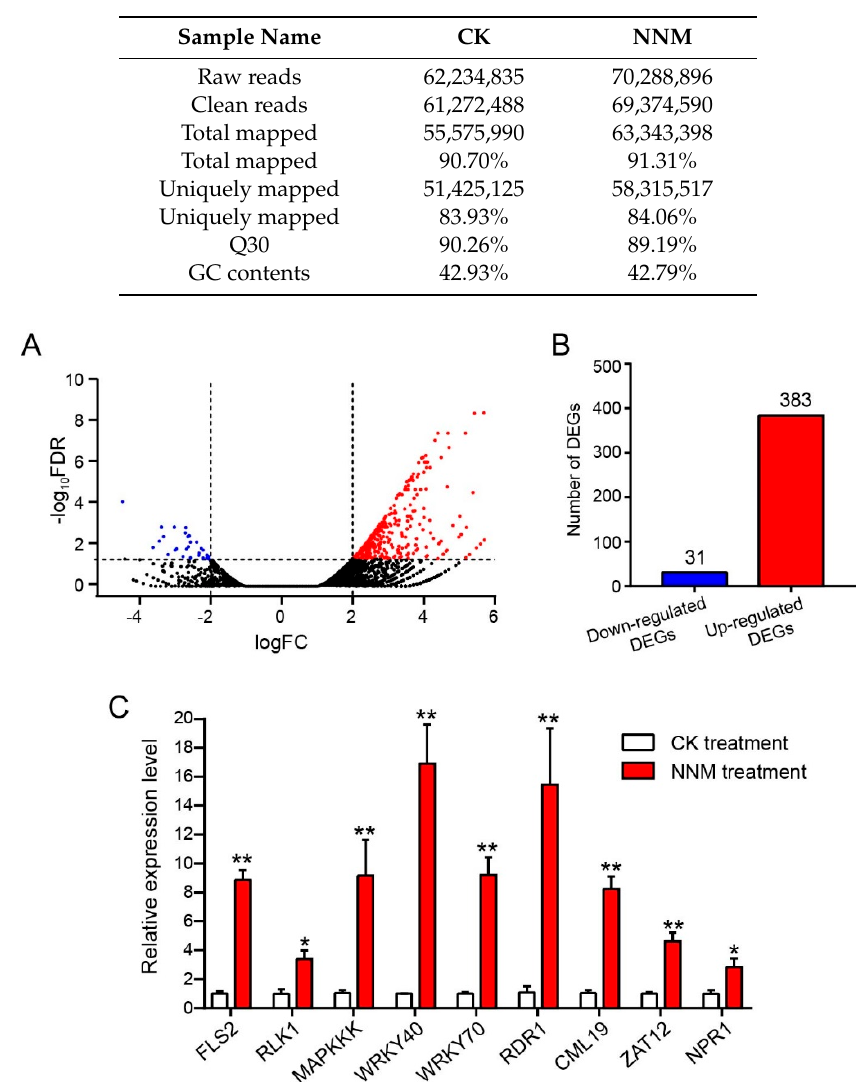
Figure 2. NNM-induced di ff erential gene expression in BY-2 protoplasts. ( A ) Numbers of up-regulated genes (in red) and down-regulated di ff erentially expressed genes (in blue) were shown (false discovery rate (FDR) < 0.05 and ≥ 2-fold change). Black dots indicate non-di ff erentially expressed genes (FDR ≥ 0.05). ( B ) Di ff erentially expressed genes (DEGs)—383 up-regulated, and 31 down-regulated—are listed. ( C ) RT-qPCR verification on regulation of nine DEGs induced by NNM. An equal volume of sterile water treatment was used as a control. * indicate a significant di ff erence ( p < 0.05) and ** indicate a significant di ff erence ( p < 0.01).